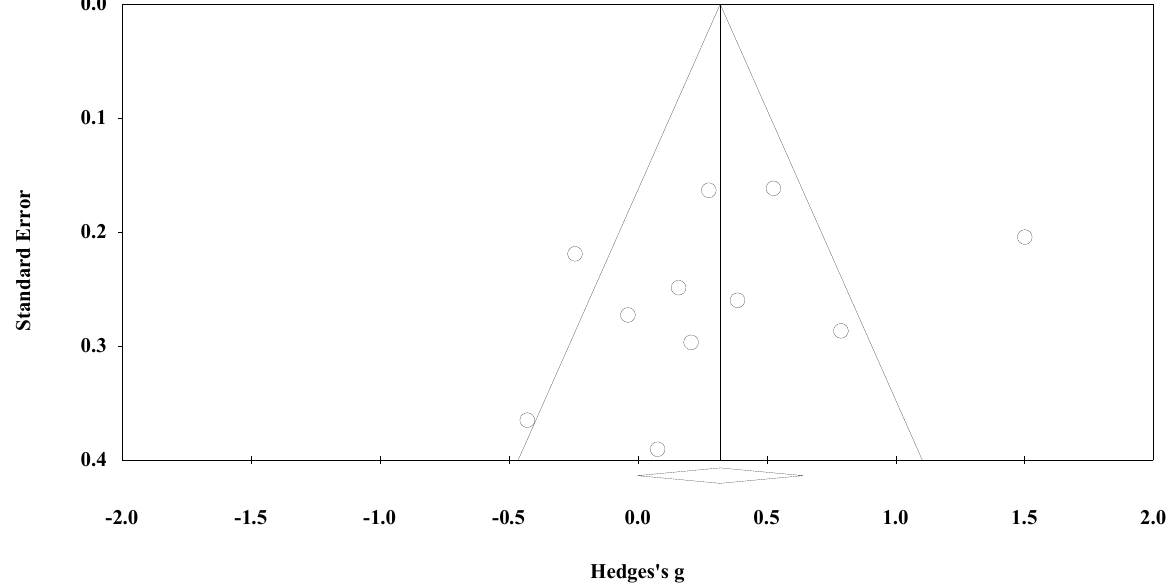
Funnel Plot for the Random Effect Model (Asynchronous vs. Synchronous) for the Affective Domain Funnel Plot of Standard Error by Hedges's